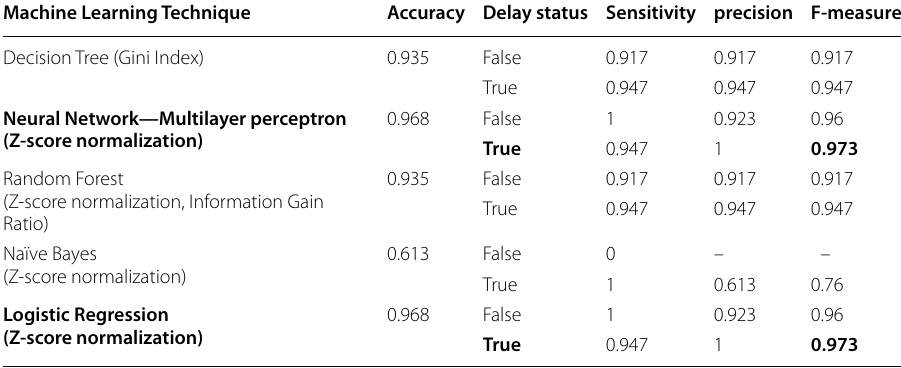
Optimal model is denoted with the bold font